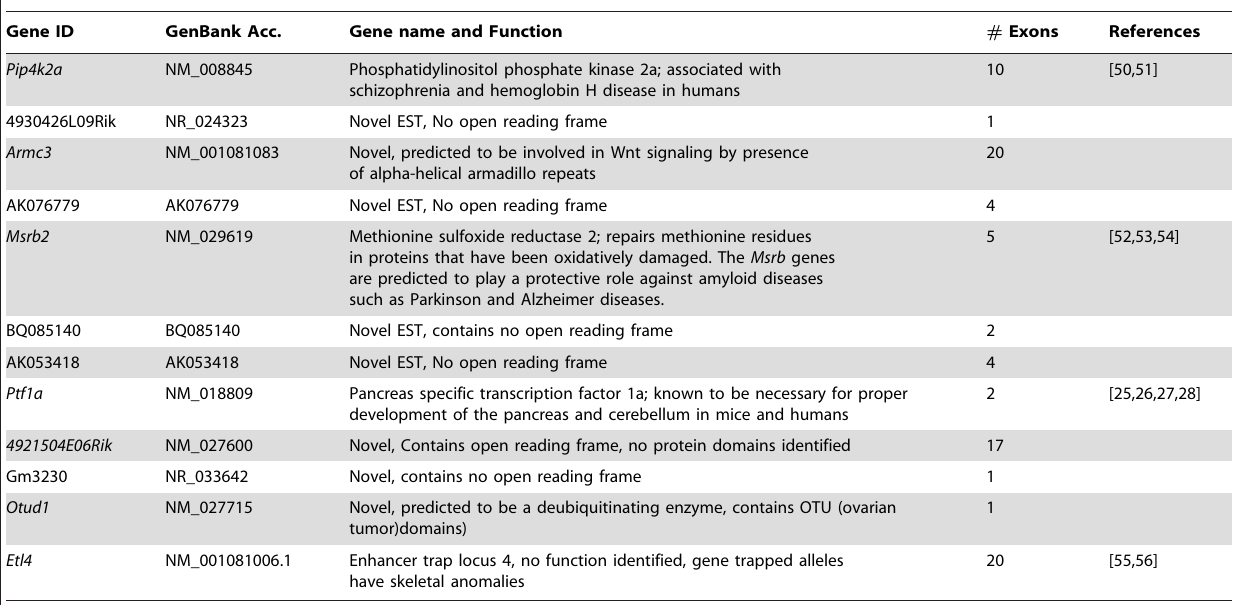
Table 1. Genes and ESTs mapping to the Sd critical region.